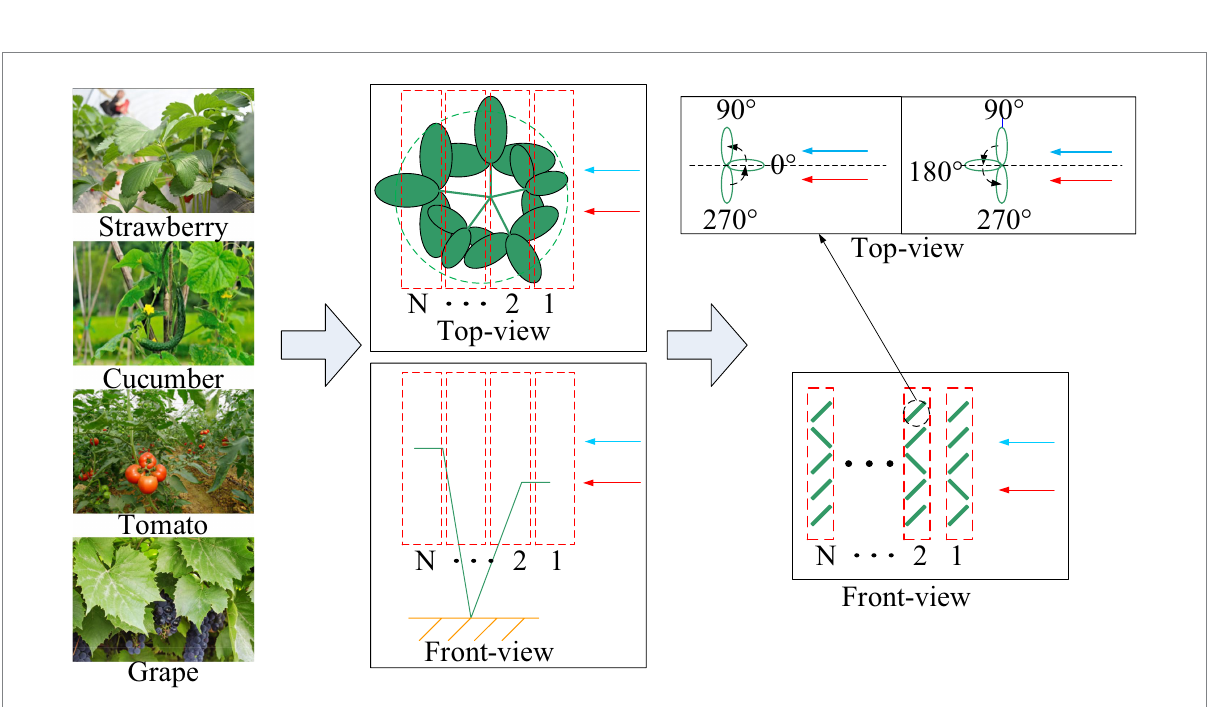
FIGURE 3 Schematic diagram of quantitative analysis of the droplet capture process in the crop